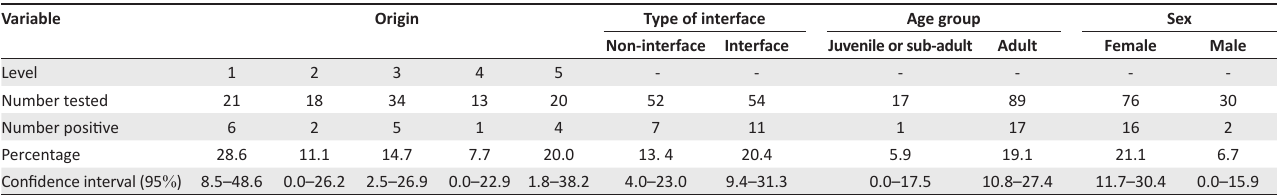
TABLE 2: The distribution of the Brucella seropositive buffalo ( Syncerus caffer ) from selected game parks in Zimbabwe.